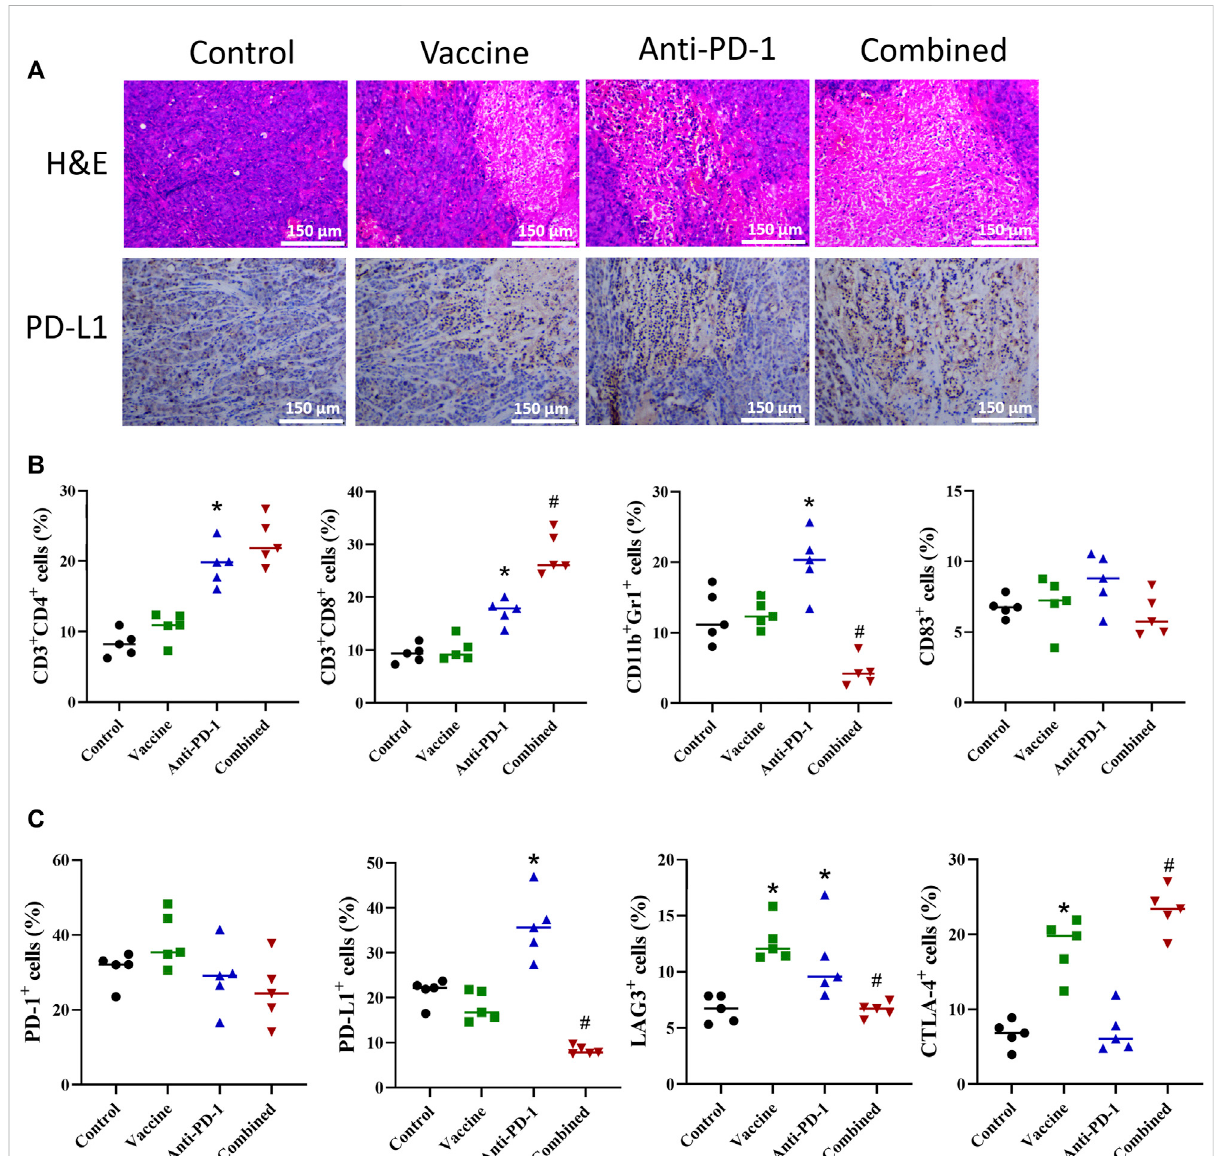
FIGURE 4 EffectofdifferentcombinationoftreatmentonTME. (A) RepresentativeH&EstainingandIHCfrommicewithdifferenttreatmentcombinations. (B – C) Flow cytometric phenotyping of cells in colon cancer TME. Statistical signi fi cance was measured using Student ’ s t-test and one-way ANOVA. *, p < 0.05 vs. Control; # , p < 0.05 vs. Anti